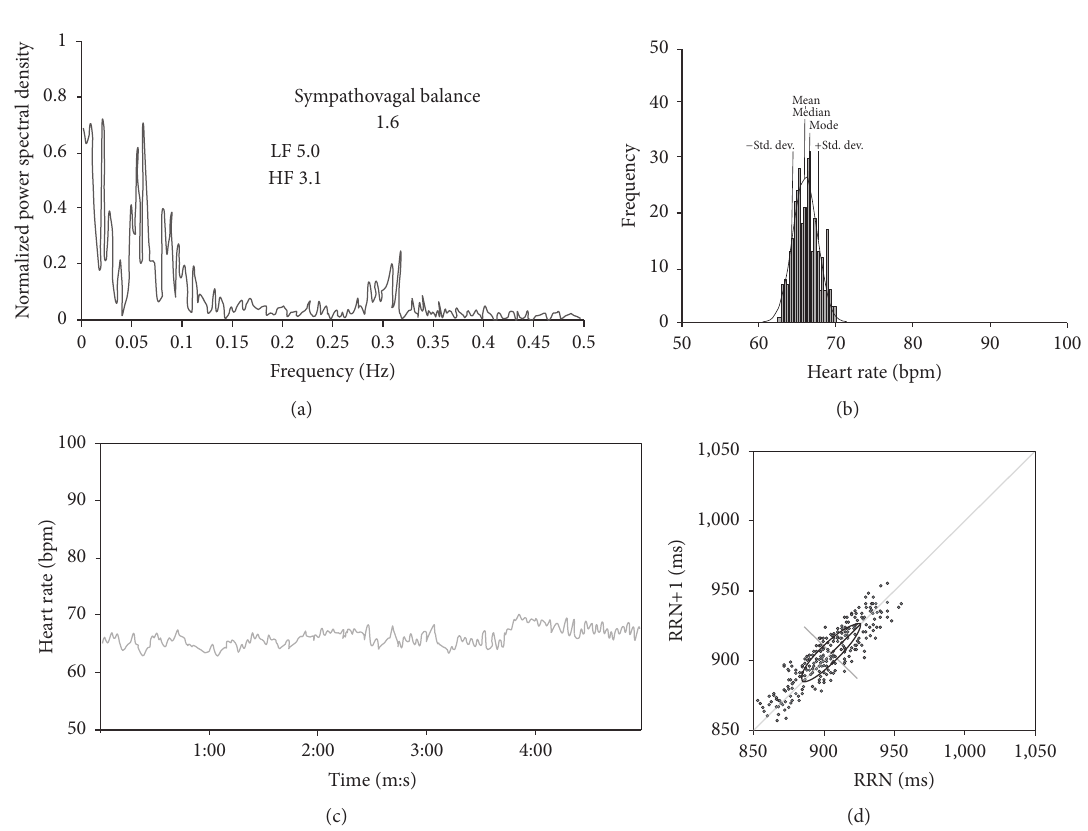
Figure 3: HRV in the standing position. (a) The total Fourier spectrum, (b) the histogram, (c) the tachogram, and (d) and the Poincar´e plot. In (a), the sympathovagal balance is included (SVB = 1.62 versus 1.5 ± 0.6 in controls). The normal SVB seems to be due to a severe reduction of the total power of HF and a less severe reduction of LF so the ratio remained normal. The total power of LF was 5.0 versus 6.2 ± 1.9 in controls, and the total power of HF was 3.10 versus 10.1 ± 3.6 in controls. There was a severe loss of variability across all